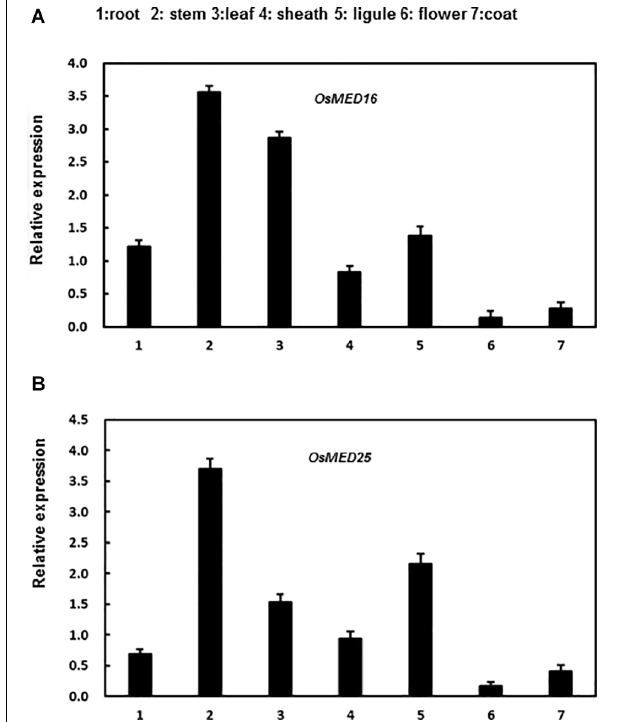
FIGURE 4 | The expression patterns of OsMED16 and OsMED25 genes in different tissues. (A) The expression patter of OsMED16 in different tissues. (B) The expression patter of OsMED25 in different tissues. Roots, flowers, stems, coats, leaves, sheaths, and ligules were collected to analyze the gene expression by qRT-PCR. Expression data were normalized against OsActin gene, and the relative expression is shown as fold expression of OsActin . Data are presented as means ± SD from three independent